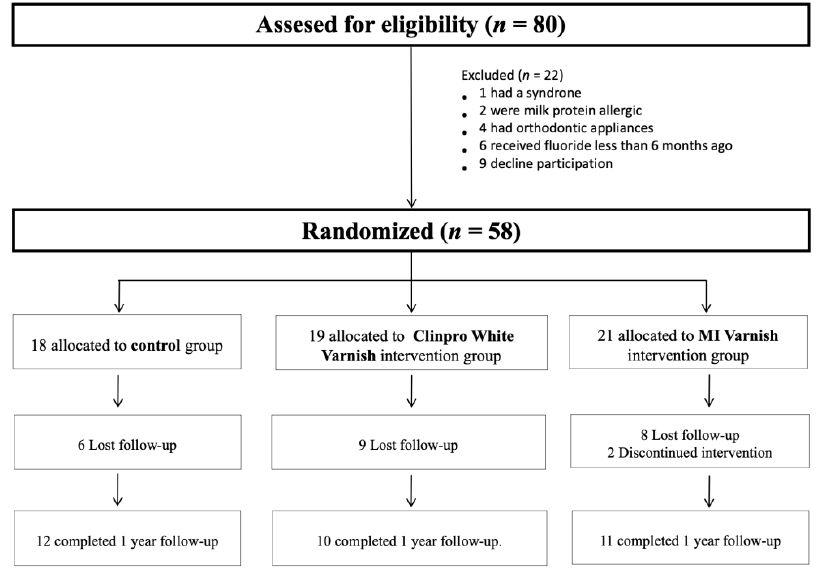
Figure 2. Flow diagram of the progress through the phases of the study. CONTROL (Placebo), CLINPRO (Clinpro White Varnish) and MI (MI Varnish).